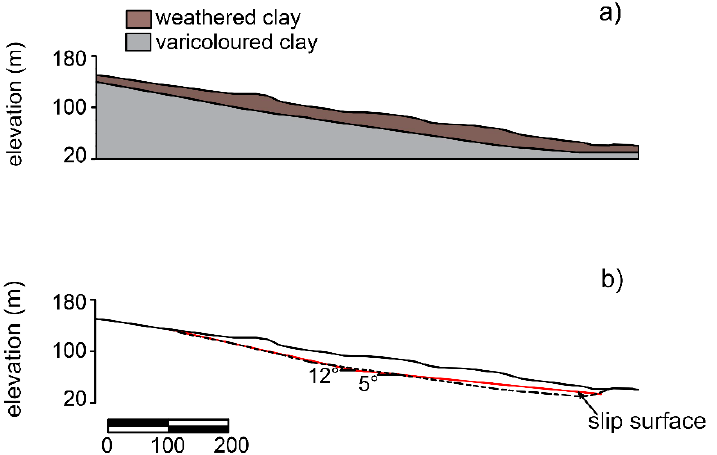
Figure 5. Section A-A’ of the Cerda landslide, whose trace is shown in Figure 4b: ( a ) longitudinal section of the slope; ( b ) bi-planar surface used in the present study to approximate the slip surface.